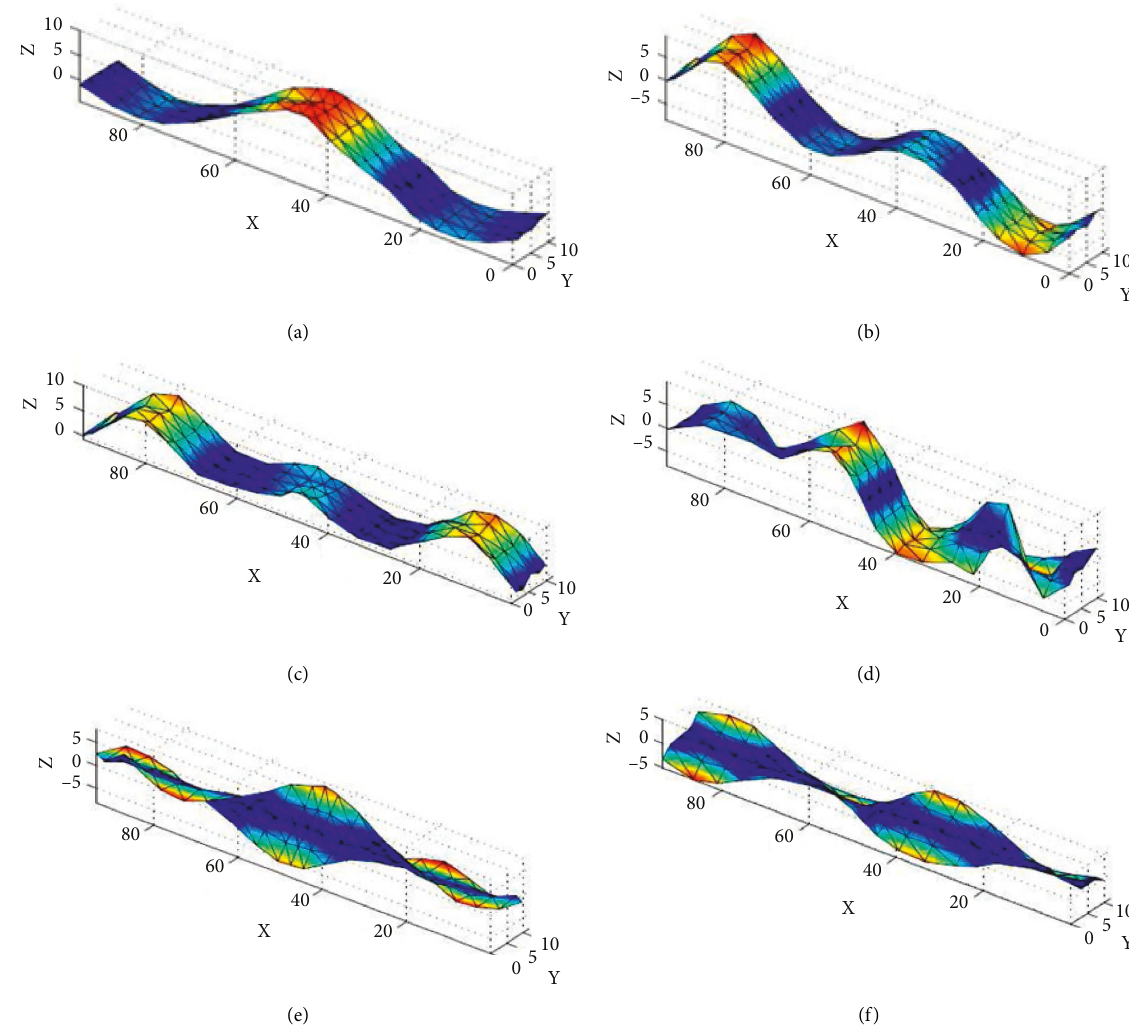
Figure 5: Representative vibration modes of the experimental results. (a) Mode 1: f